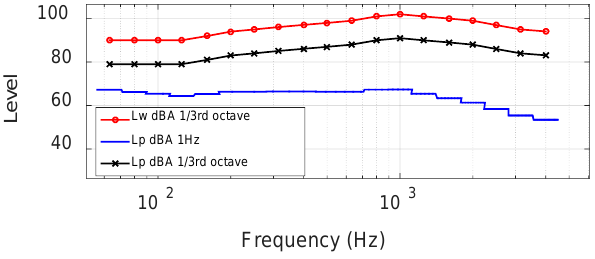
Figure 10. A-weighted sound power level ( Lw ), SPL ( Lp dBA 1/3 rd octave) equivalent spectra of road traffic noise at 1/3 rd octave frequency band and 1 Hz resolution band ( Lp dBA 1 Hz).